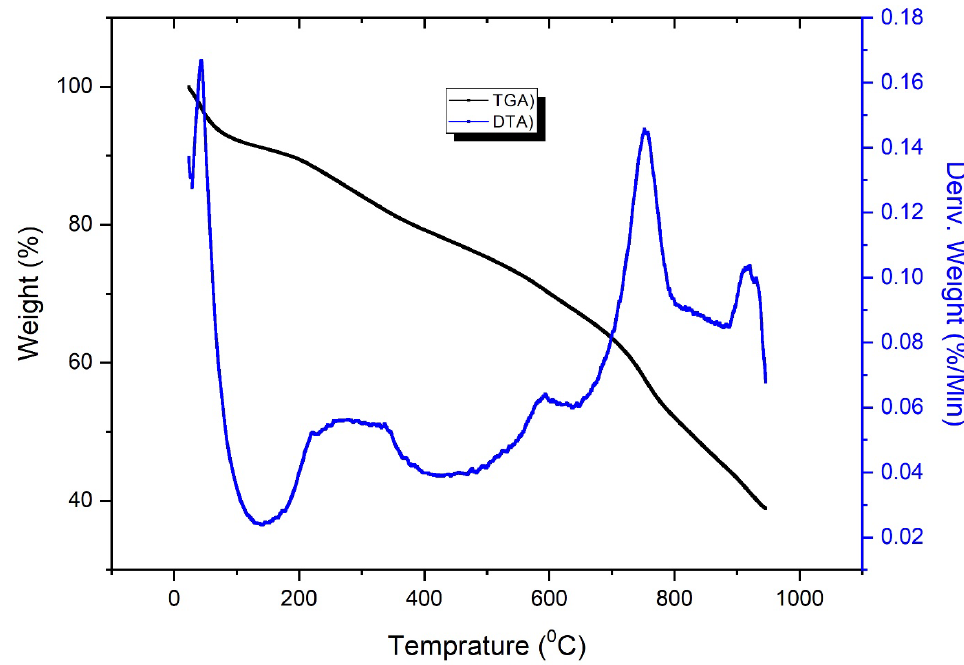
Figure 2. Thermogravimetric analysis curve (TGA—black in color) for the PNMPy/nano-Stannous(II)WO 3 composite in a nitrogen atmosphere while differential thermal analysis (DTA—blue) is shown for reaction endothermic or exothermic.